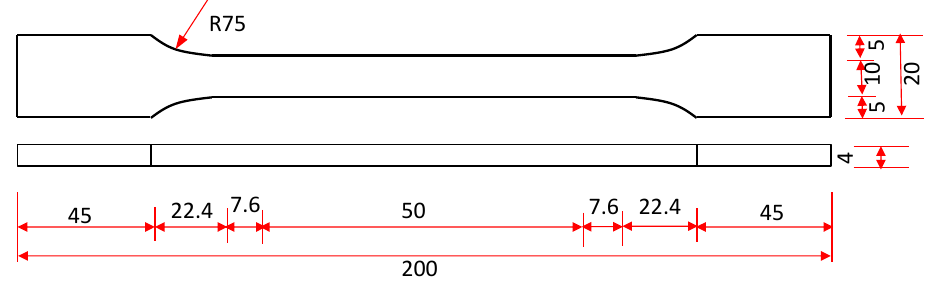
Figure 4. Details of resin plate specimens (in mm).